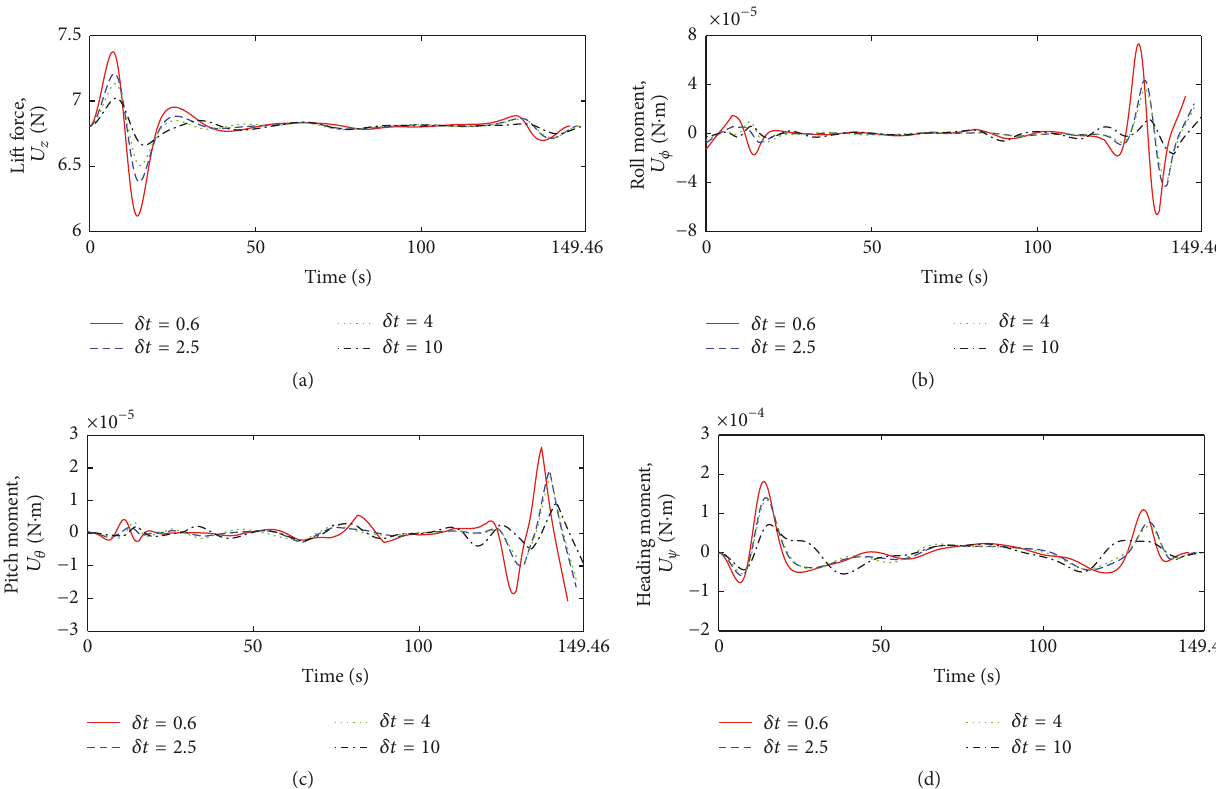
Figure 14: Induced efforts: (a) lift force and aerodynamical (b) roll and (c) pitch and (d) heading moments, respectively.